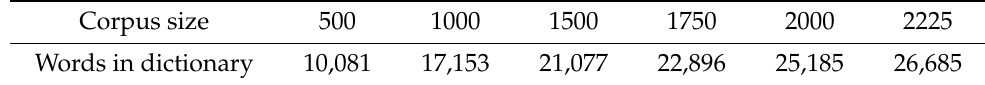
Figure 3. Storage efficiency. Table 1. The number of words in dictionary.